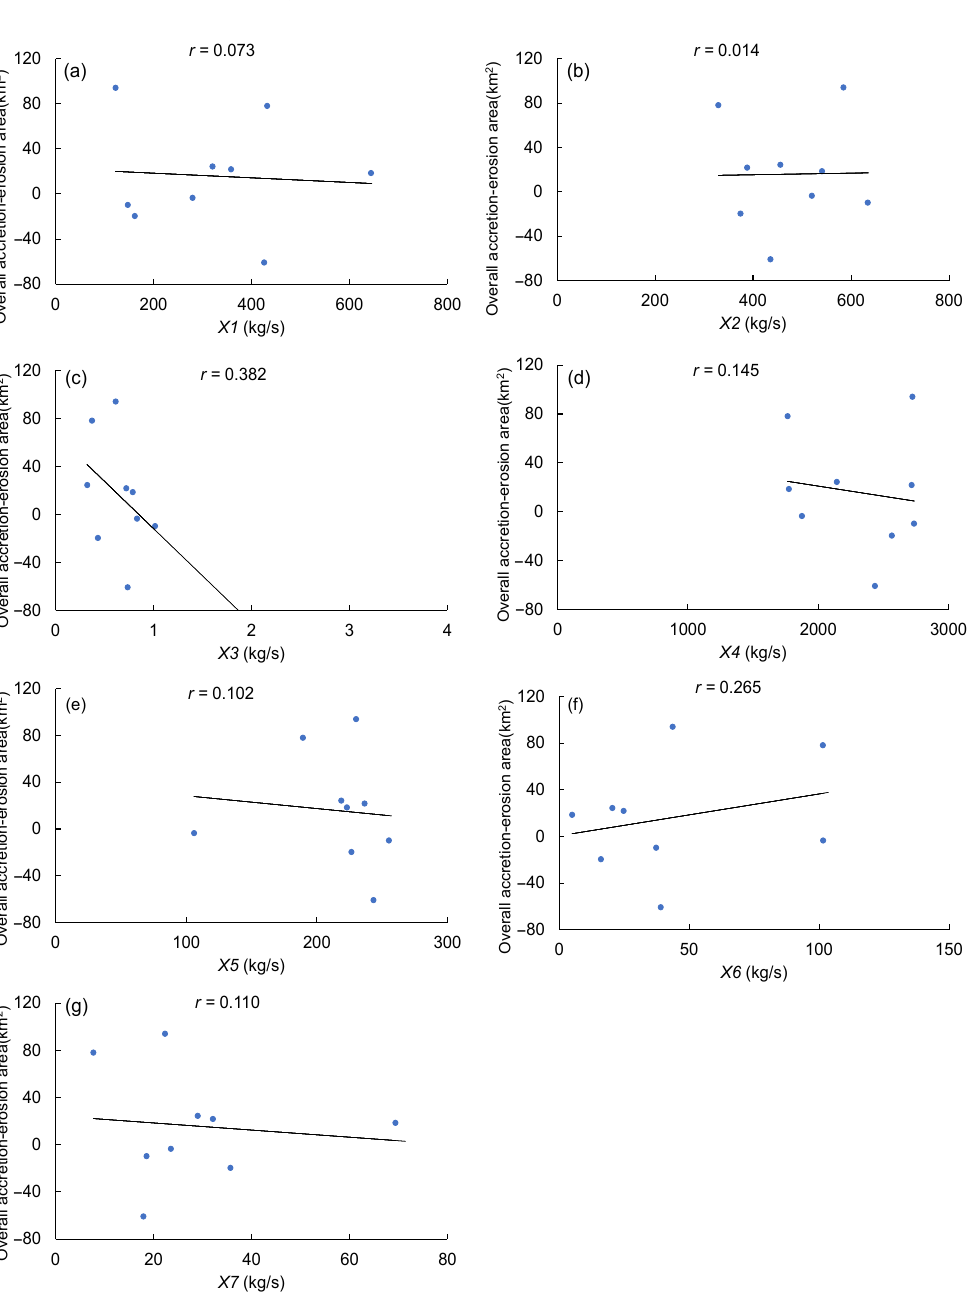
Figure 12. Relationship between each hydrological variable and the overall accretion–erosion area of the Tongtian River . X1 is the average annual sediment-transport rate (kg/s). X2 is the average annual streamflow (m 3 /S). X3 is the average annual sediment content (kg/m 3 ). X4 is the water-body area (km 2 ). X5 is the unchanged area of the river (km 2 ). X6 is the accretion area (km 2 ). X7 is the erosion area (km 2 ). The black line is the linearly fitted line between the single-input hydrological variable and the prediction value of the overall accretion–erosion area of the Tongtian River. r is the correlation coefficient of the two variables. All the correlation coefficients do not pass the significant